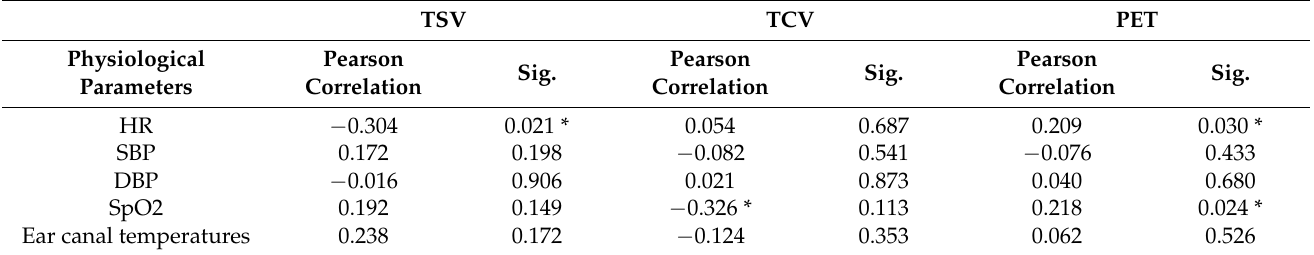
Table 10. Correlation analysis between physiological parameters and thermal indices.